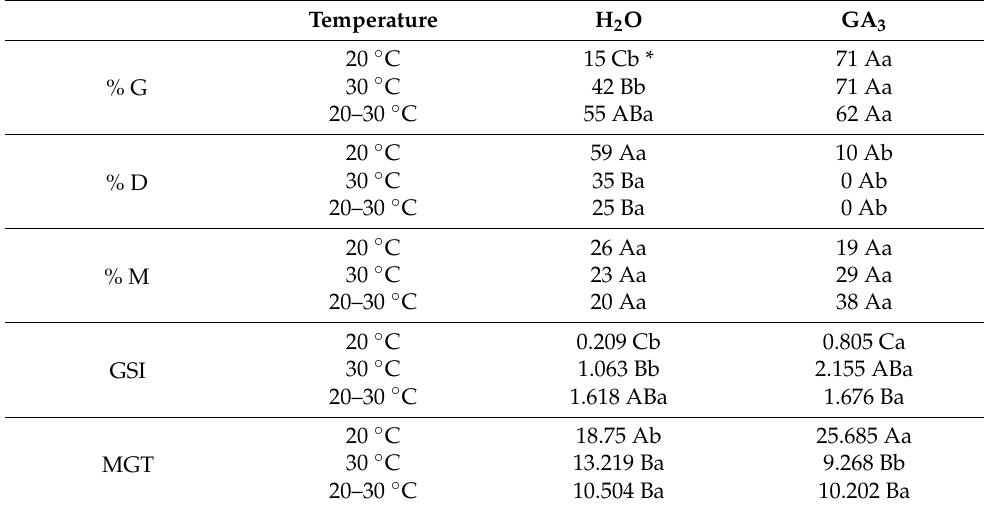
Table 4. Germinability (Germination percentage-% G; Percentage of dormant seeds-% D; Percentage of dead seeds-% M; Germination speed index-GSI; Mean germination time-MGT) of Annona x atemoya Mabb. cv. ‘Gefner’ seeds immersed for 36 h (H 2 O or GA 3 ) at temperatures of 20 ◦ C, 30 ◦ C, and 20–30 ◦ C and kept at the same temperatures during